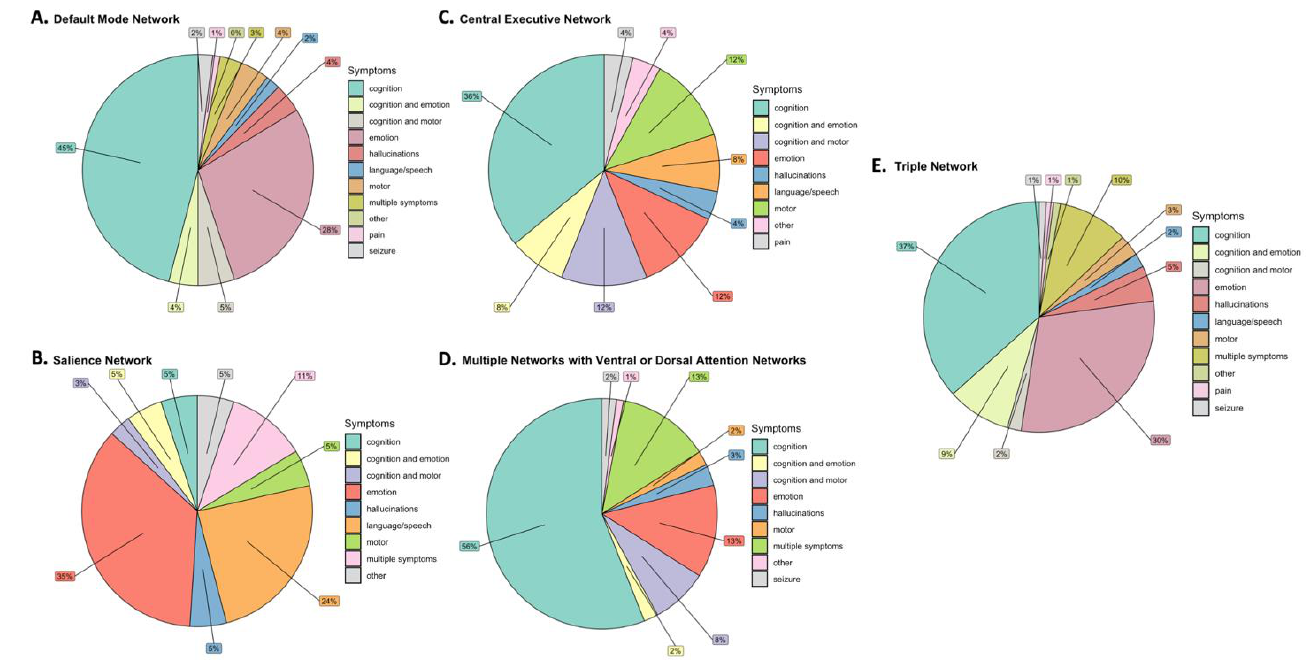
Figure 2. Deficits Associated with Network Disturbances. Deficits are presented based on relative frequency for the ( A ) Default Mode Network (DMN), ( B ) Salience Network (SN), ( C ) Central Exec- utive Network (CEN), ( D ) Ventral or Dorsal Attention Network in combination with each other or the other networks, and ( E ) Triple network combination of the DMN, SN, and CEN. Different colors represent different deficits as shown in the figure legend.